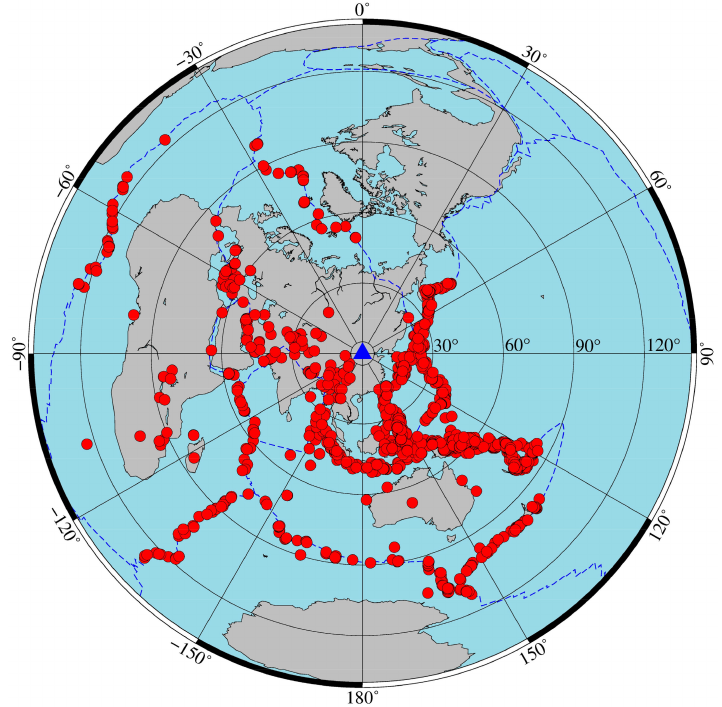
Figure 2. Distribution of 1347 earthquakes used in this study. Although some events are located inside 20 ◦ and outside 120 ◦ , all three component waveforms have the epicentral distance between 20 ◦ and 120 ◦